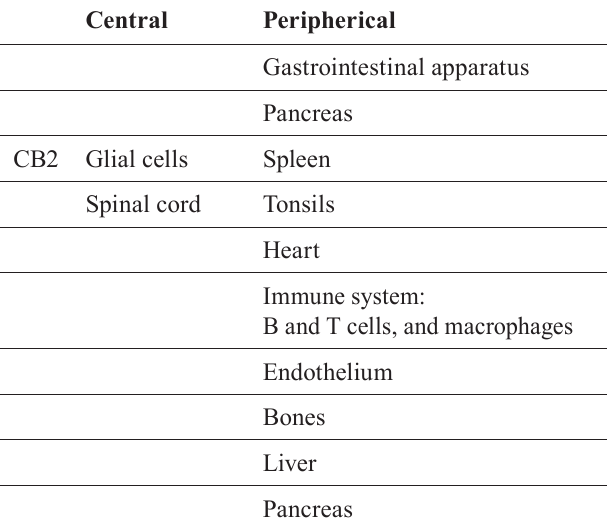
TABLE VI - CB1 and CB2 distribution in the organism (Howlett, Abood, 2017; Cassano et al. , 2020)